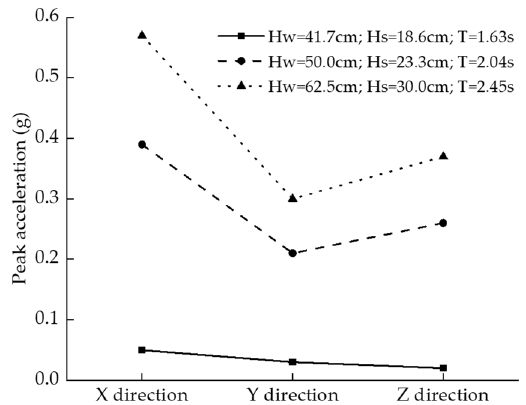
Figure 13. Peak acceleration of the platform under waves of large wave height.